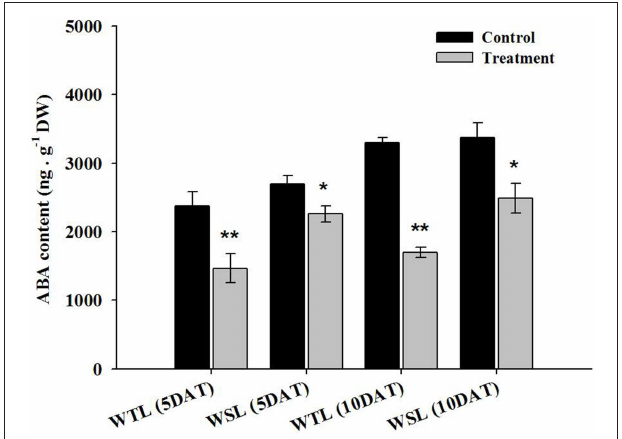
FIGURE 4 | Proline contents in the two soybean lines after waterlogging treatment. In the figures, WTL denotes the waterlogging tolerant line (PI408105A) and WSL indicates the waterlogging susceptible line (S99-2281). In the figure, star marks indicate a significant difference between control and treatment at P < 0 . 05 or P < 0 . 01 . Data is the average ± standard error ( n = 3